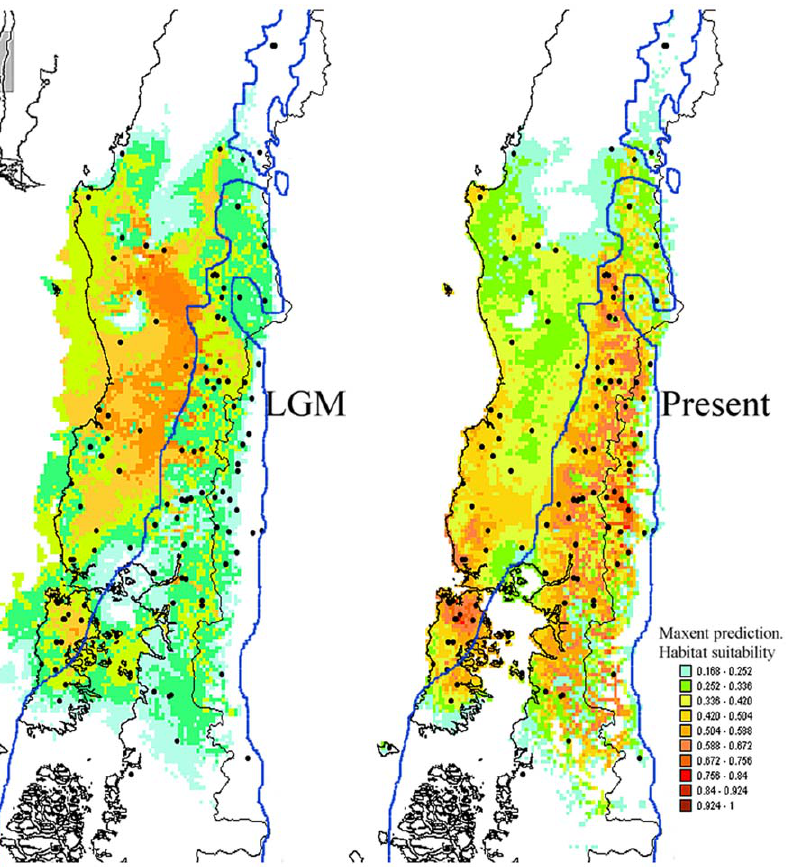
Figure 7. Present and LGM potential distribution for L.pictus estimated from Ecological Niche Modeling (ENM). The color scale corresponds to the probability for suitable habitat; red and light blue indicate highest and lowest suitability values respectively. The heavy blue line delimits the maximum extension of ice shield during LGM according to Heusser [11].